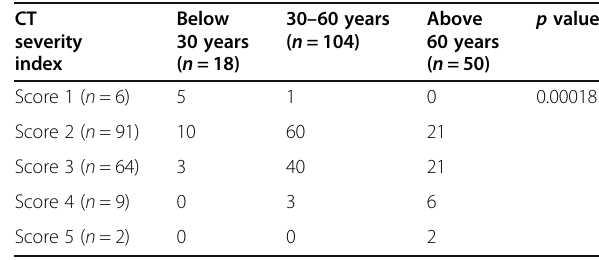
Table 4 Correlation between CT severity index and age